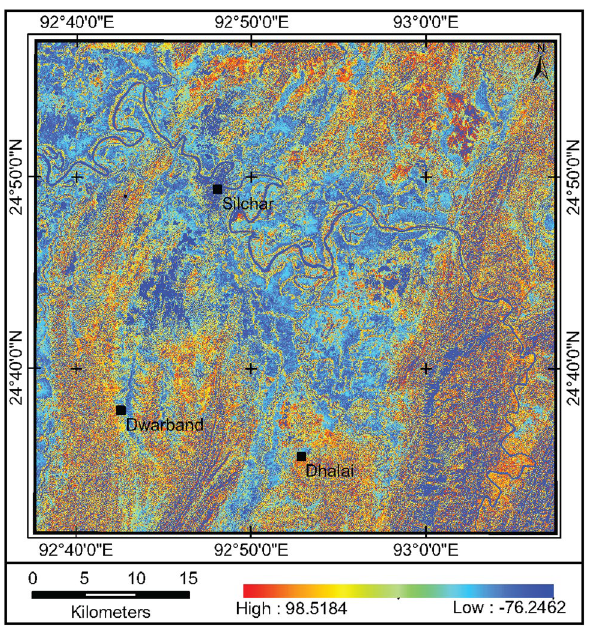
Fig. 5 PC image 1345PC2 indicating areas of ferrous iron (Fe 2+ ) mineral abundance as low pixel values